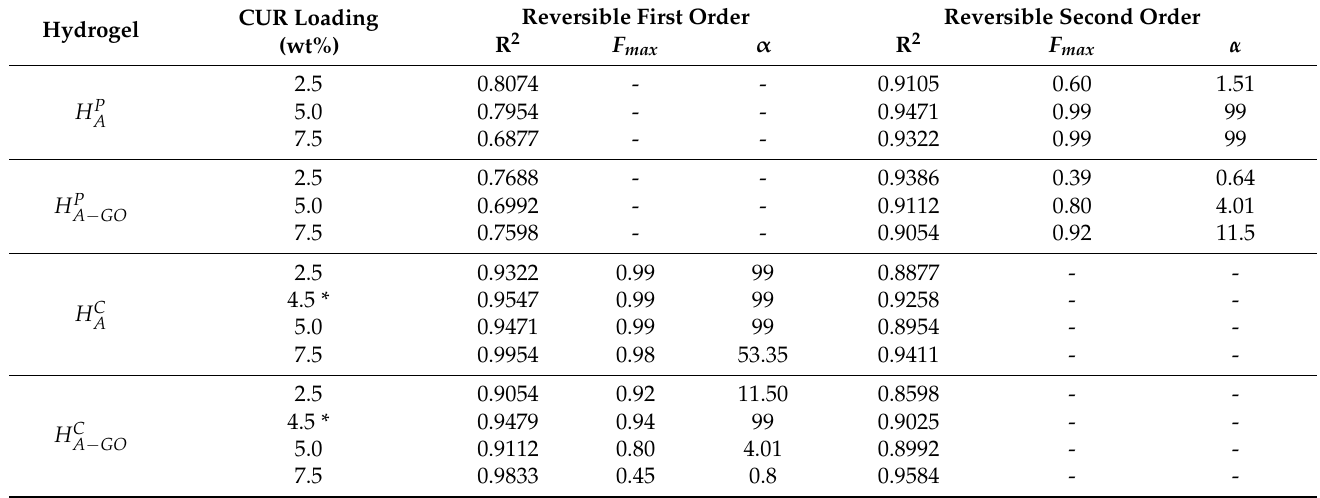
and H P ) and blank ( H C A − GO A − GO A